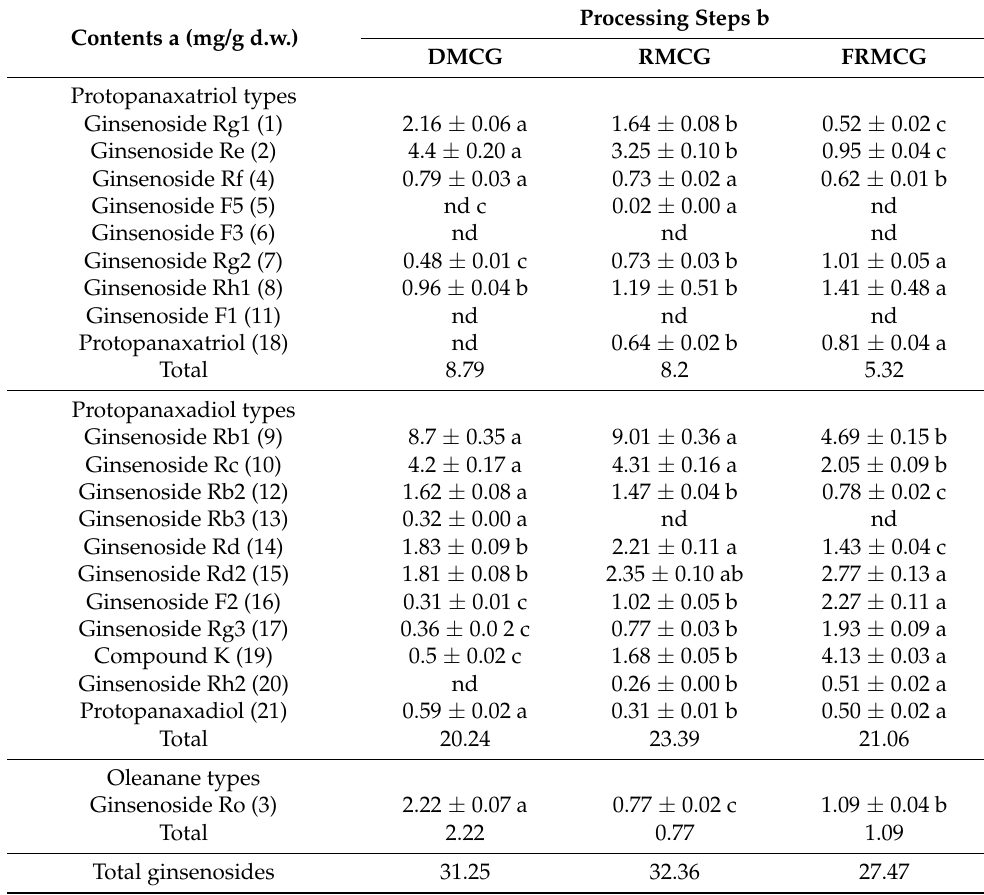
Table 4. Change of the ginsenoside contents during food processing steps of mountain-cultivated ginseng by the cocktail lactic acid bacteria. Contents a (mg/g